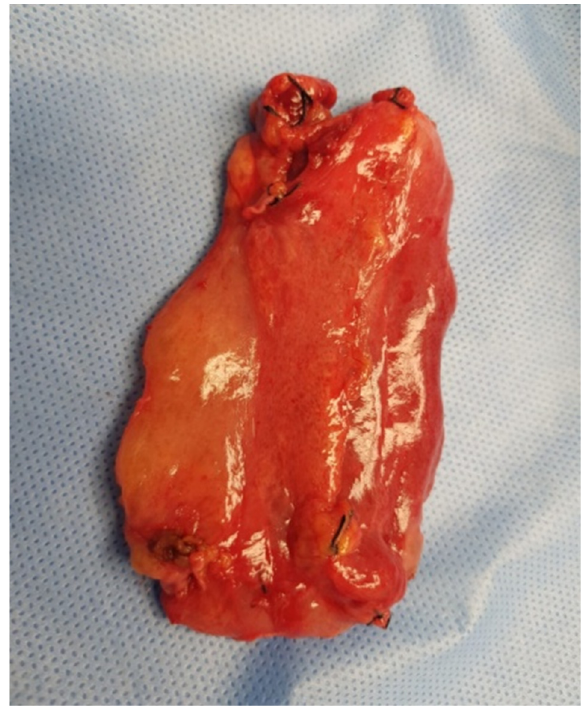
Figure 3. The excised specimen following the operation. The size of the specimen is 7 × 5 cm.